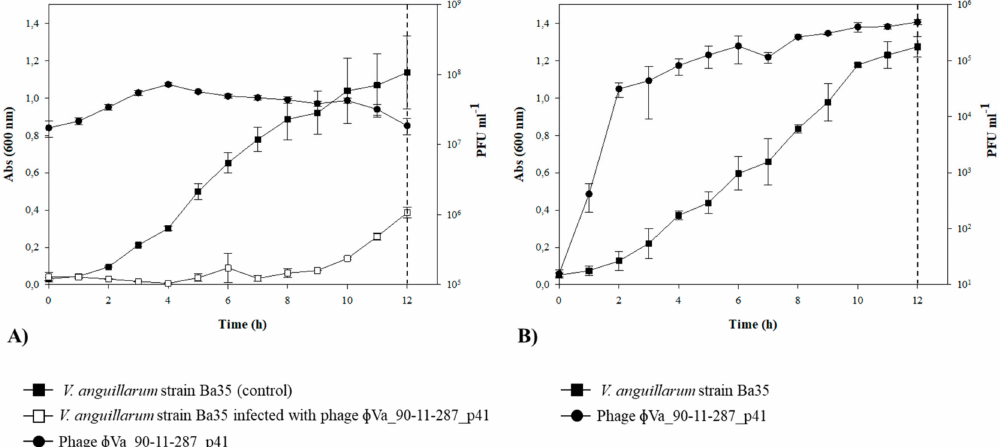
Figure 4. In vitro cell infection experiment of bacteriophage Φ Va_90-11-287_p41 against V. anguillarum strain BA35. ( A ) Optical density (OD 600 ) of cultures of V. anguillarum strain Ba35 amended with phage Φ Va_90-11-287_p41 and control cultures without phage. ( B ) Representative spontaneous release of phage Φ Va_90-11-287_p41 from one lysogenized isolate. PFU mL − 1 counting was measured every hour. Dotted vertical lines represent time-points of bacterial ( A ) and phage ( B ) isolation. Error